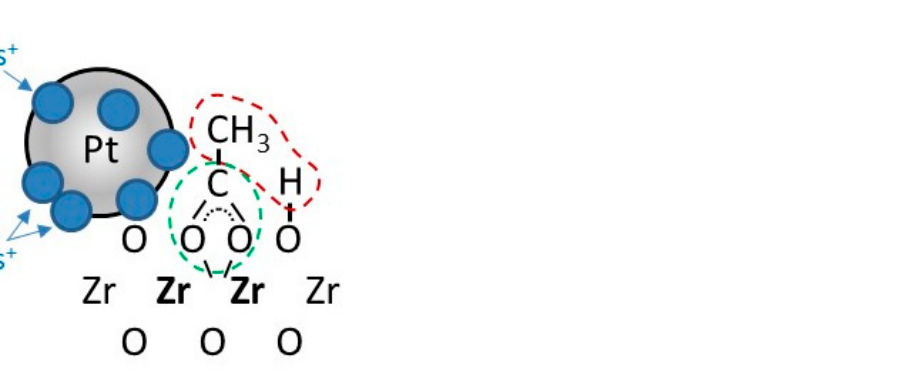
Scheme 1. The effect of an optimal loading of Cs + on the decomposition selectivity of acetate intermediate is C–C bond weakening, promoting scission to CO 2 and CH 4 .